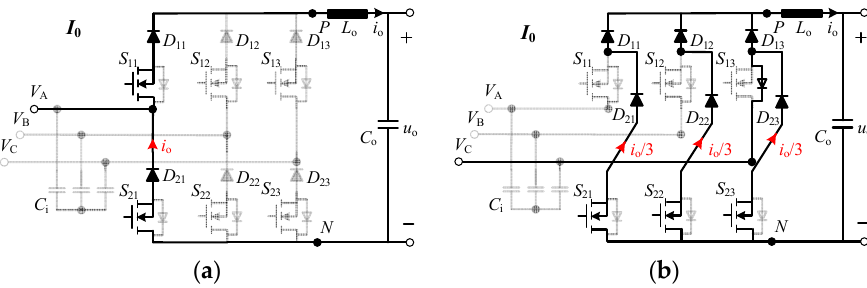
Figure 8. Current stress in the freewheeling mode. ( a ) Conventional CSR. ( b ) Proposed CSR.